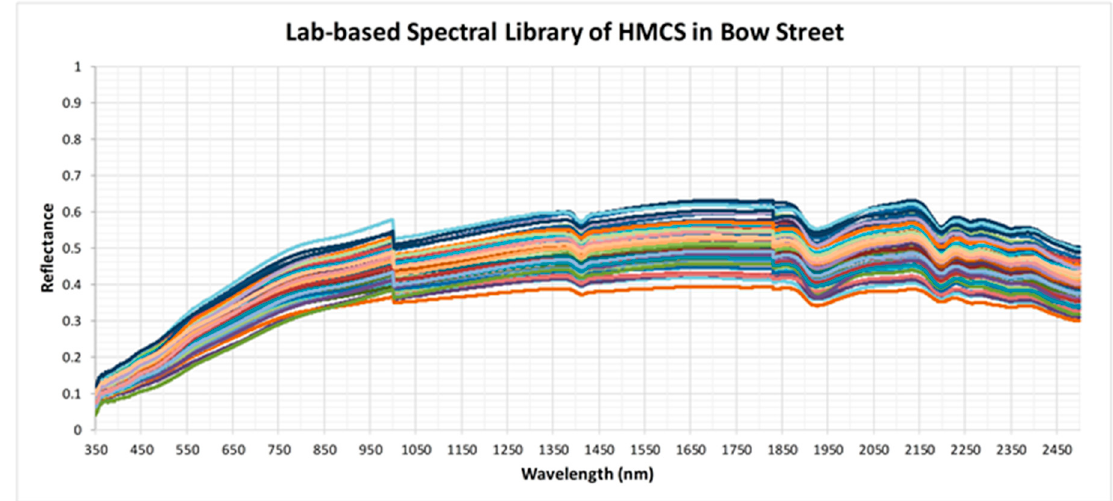
Figure 7. Lab-based spectral library of the heavy metal soil contamination (HMSC) at the Bow Street site.